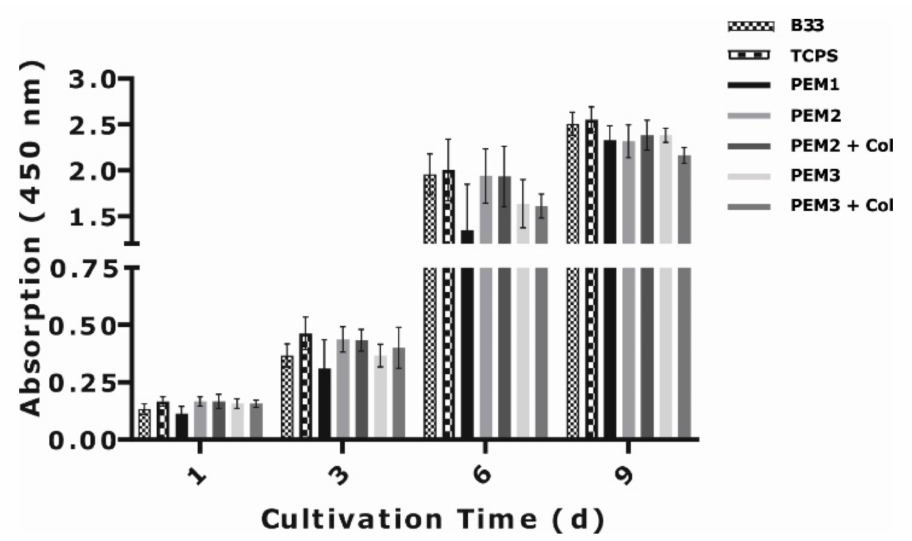
Figure 7. XTT assay for MC3T3 cells cultivated on different PEM films. For PEM2 and PEM3 collagen or Hep was chosen as final cover layer.